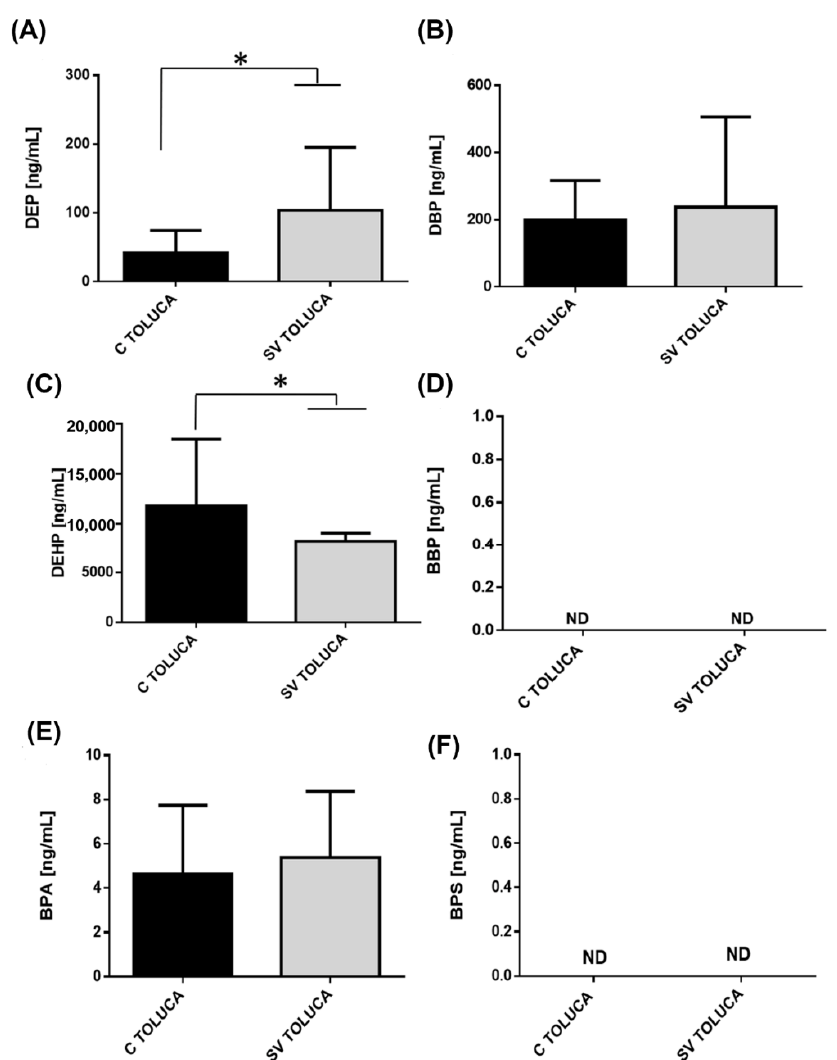
Figure 5. Levels of phthalates and bisphenols in survivors of BC in Toluca City. Serum concentration levels of phthalates measured in the Toluca City population among controls, and survivors. The image displays the different serum concentrations of ( A ) DEP, ( B ) DBP, ( C ) DEHP, ( D ) BBP, ( E ) BPA, and ( F ) BPS in the control group (black bar) and in women survivors of BC disease (gray bars). Bars represent the mean ± S.D. * p < 0.05 was considered statistically significant. ND = not detected. Table 3. Serum levels of EDCs in the 3 groups used to the study: controls, women with BC, and survivors of BC.